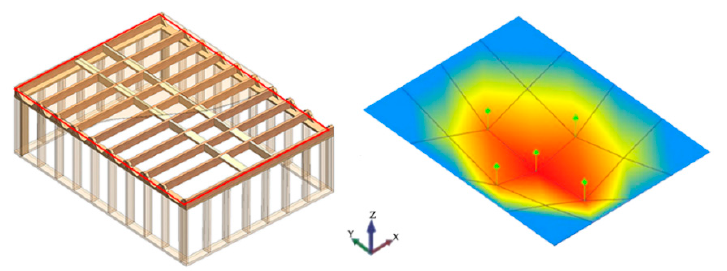
Figure 11. Measured fundamental vibration mode for the Lab-3.1-W floor (20.32 Hz Enhanced Frequency Domain Decomposition (EFDD) method). Extracted form ARTeMIS Modal Pro [21].